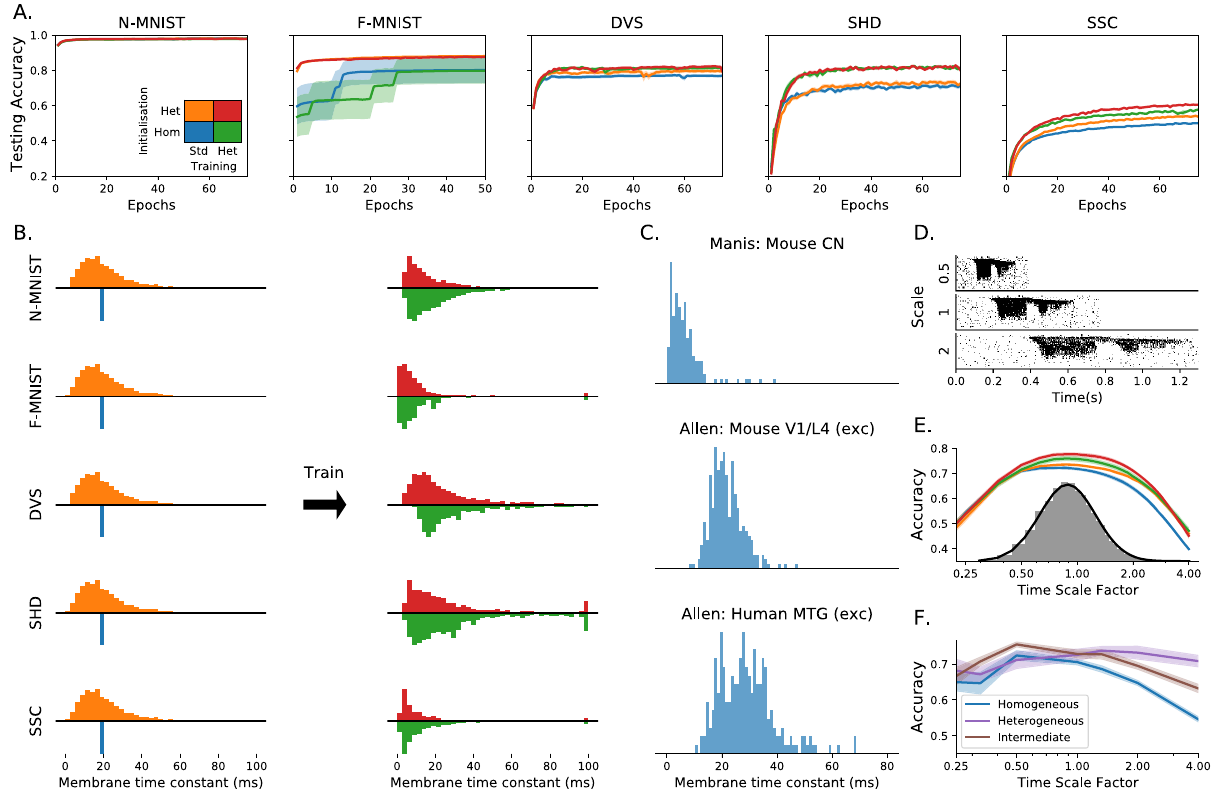
Fig. 2 Impact of training con fi guration and temporal structure of the dataset on the testing accuracy, membrane time constant distributions and performance when training at different time scales. A Improvements in accuracy in testing data, for datasets with low (N-MNIST, F-MNIST), intermediate (DVS) and high (SHD) temporal complexity. Shaded areas correspond to the standard error of the mean over 10 trials (which in some cases is too small to be visible). Initialisation can be homogeneous (blue/green) or heterogeneous (orange/red), and training can be standard, weights only (blue/ orange) or heterogeneous including time constants (green/red). Heterogeneous con fi gurations achieve a better test accuracy on the more temporally complex datasets. Heterogeneous initialisation also results in a more stable and robust training trajectory for F-MNIST, leading to a better performance overall. B Membrane time constant distributions before (left) and after (right) training for each dataset. Histograms above the axis represent heterogeneous initialisation, and below the axis homogeneous initialisation. In the case of standard training (weights only), the initial distribution (left) is the same as the fi nal distribution of time constants after training. C Experimentally observed distributions of time constants for (top to bottom): mouse cochlear nucleus, multiple cell types (172 cells) 20,21 ; mouse V1 layer 4, spiny (putatively excitatory) cells (164 cells) 22,23 ; human middle temporal gyrus, spiny cells (236 cells) 22,23 . D Raster plot of input spikes from a single sample of the SHD dataset (spoken digits) at three different time scales. E Accuracy on the SHD dataset after training on a variety of time scales (randomly selected from the grey distribution) for the four con fi gurations described in A . F Accuracy on the SHD dataset when the initial distribution of time constants is tuned for time scale 1.0, but the training and testing is done at different time